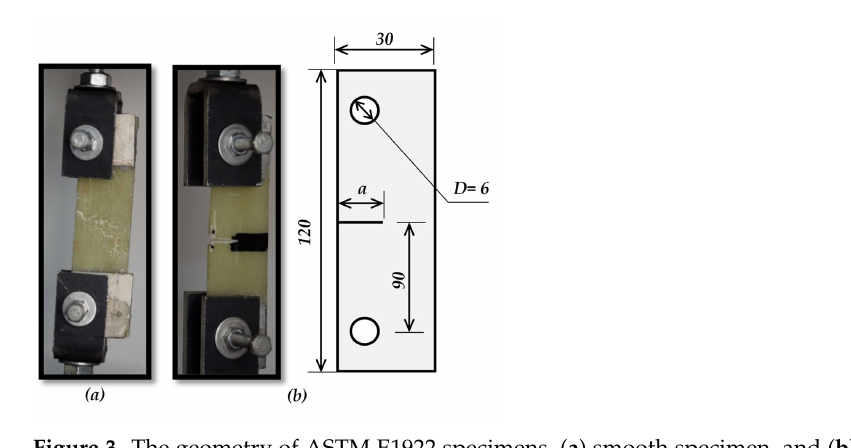
Polymers 2021 , 13 , x FOR PEER REVIEW Figure 2. Preparation of matrix crack by wax and DMF. Figure 2. Preparation of matrix crack by wax and DMF.